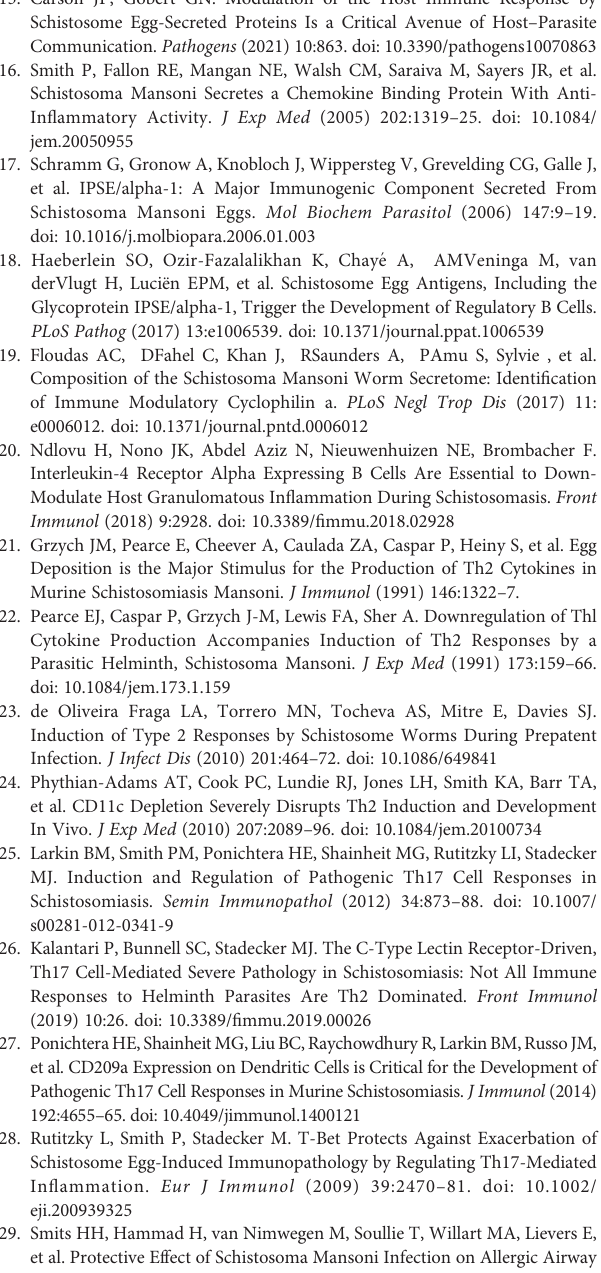
Supplementary Figure 1 | Development of hepatic pathology and antibody responses during S. mansoni infection. (A) The total number of schistosome eggs per gram of liver or intestinal tissue. (B) Visualisation of hepatic granulomas at 36, 39, 42, 45, 48 and 51 days post infection (DPI). Representative images of liver sections stained with Masson ’ s Trichrome (MT) (C) Quanti fi cation of granulomatous in fl ammation. (D) Quanti fi cation of positive CD11C, TCR b and Siglec-F staining in liver sections. (E) SEA-speci fi c IgG, IgG1, IgG2c and IgG3 titres in the serum of naïve and infected mice, presented as endpoint serum dilutions. (F) Serum IgE titres, presented as concentration. (G) Liver and spleen weights for infected mice with data represented as a proportion of total body weight. Data are from a single experiment (B – F) or pooled from 2 (G) or 3 separate experiments (A) , with 3-18